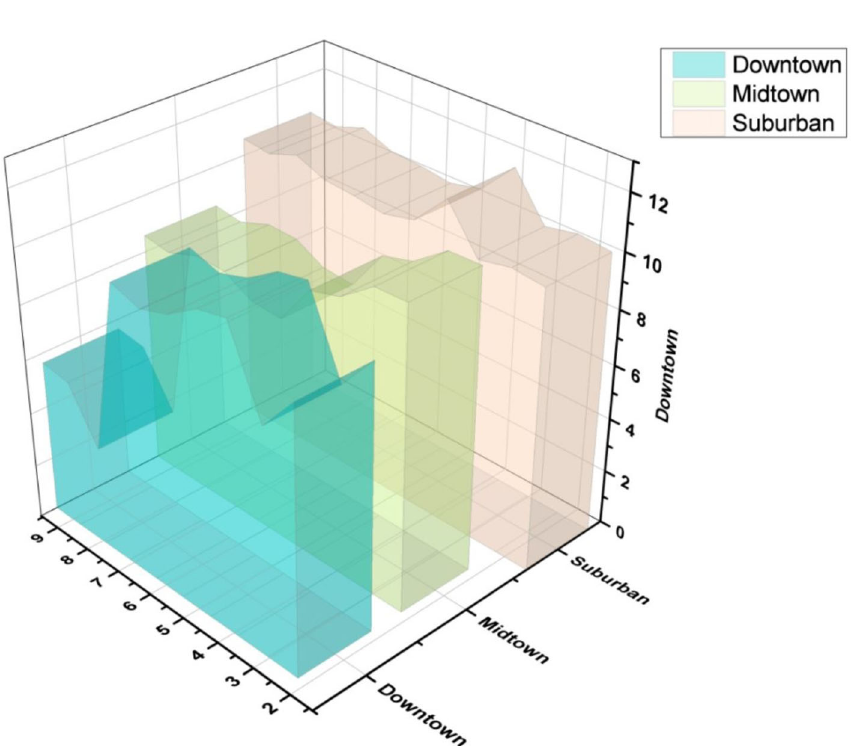
Figure 7. Demand for occupancy by